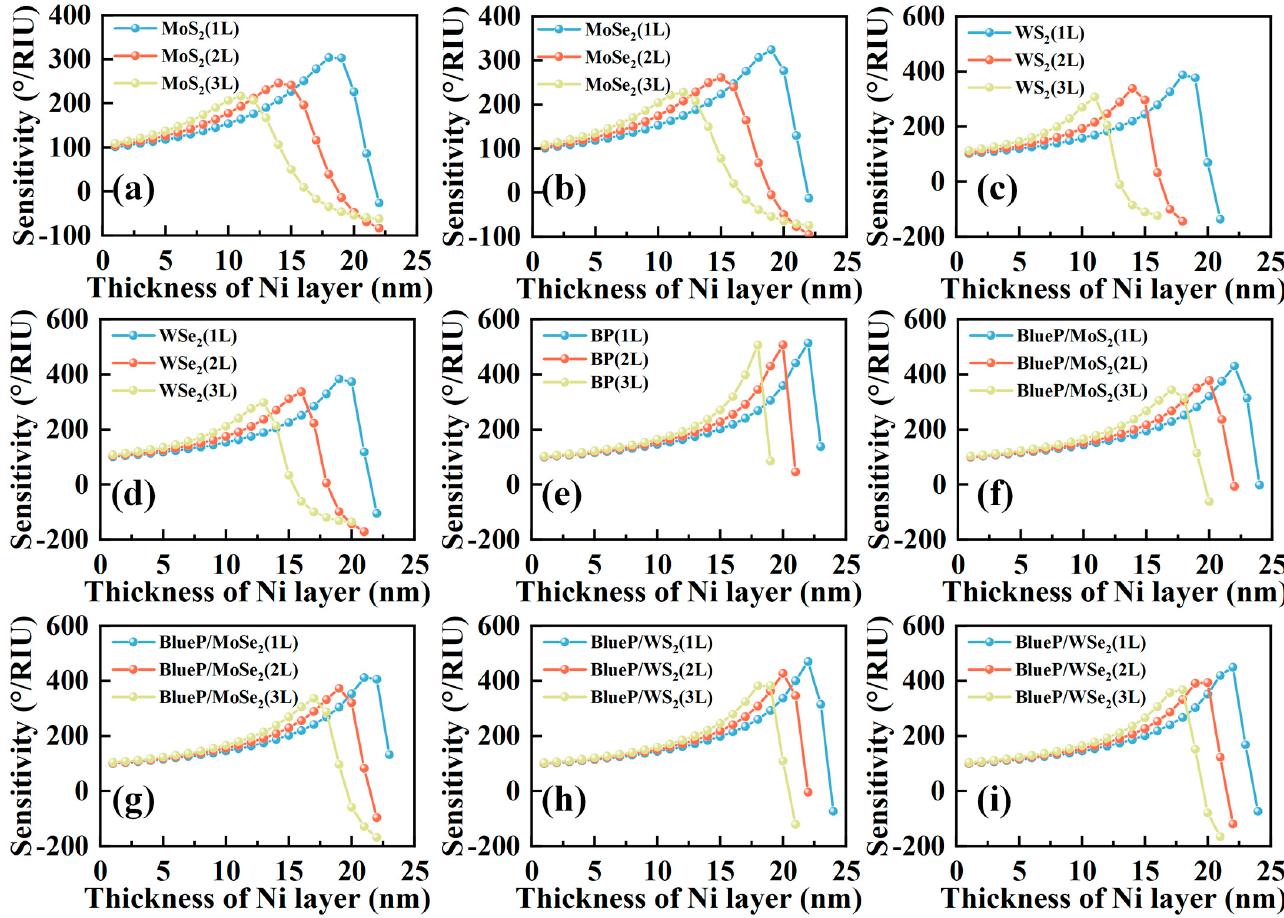
Figure 4. The sensitivity of SPR sensors with different 2D materials: ( a ) MoS 2, ( b ) MoSe 2, ( c ) WS 2, ( d ) WSe 2, ( e ) BP, ( f ) BlueP/MoS 2, ( g ) BlueP/MoSe 2, ( h ) BlueP/WS 2, ( i ) BlueP/WSe 2 .